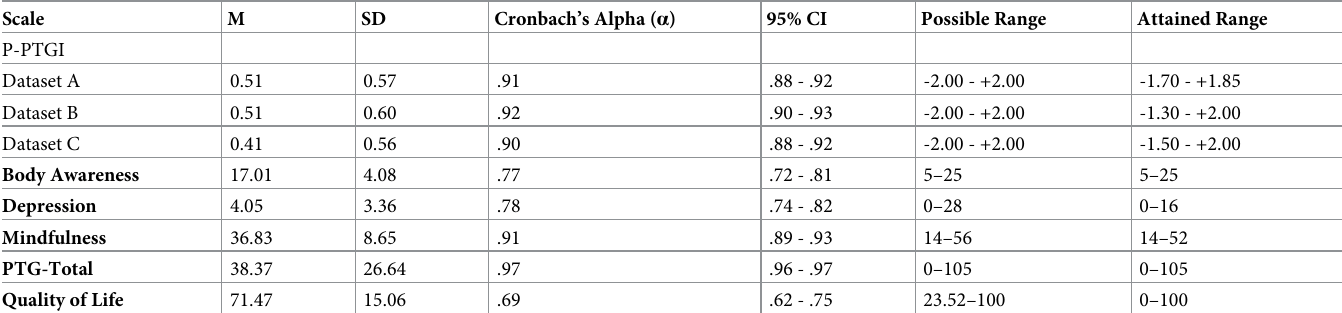
Table 4. Descriptive statistics for P-PTGI and validation